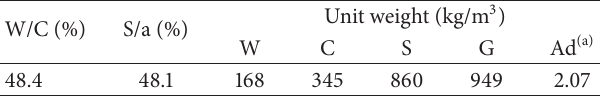
Table 1: Mixture properties of concrete.